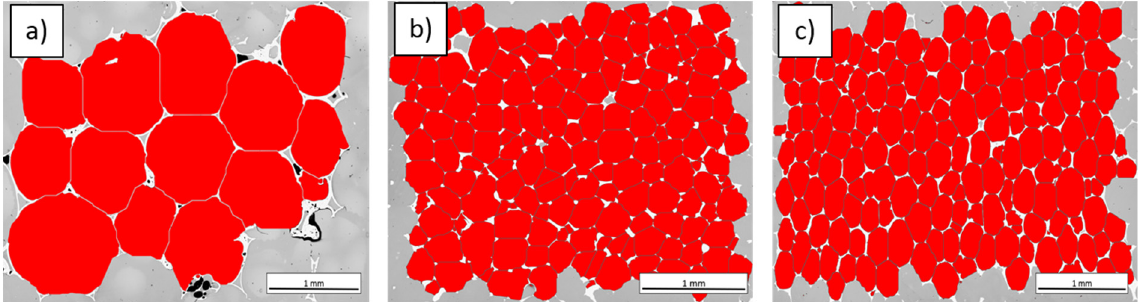
Figure 5. Detection of spheres in examined C of - epoxy composites with different foam porosity: (a) C of 20 ppi, (b) C of 40 ppi and (c) C of 60 ppi.